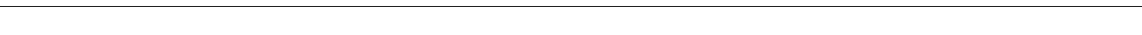
Fig. 4 Epigenetic features of H2A.Zac re-distribution at genomic regulatory regions. LHS, Venn diagrams overlapping the H2A.Zac gained or lost peaks from each different regulatory region (from Fig. 3a) with the corresponding “ unique ” active enhancers a , poised enhancers b , active promoters c and bivalent promoters d . The terminology “ unique ” was used to call enhancers or promoters that were only present in LNCaP but not in PrEC, for the gained peaks; and the enhancers and promoters that were only present in PrEC but not in LNCaP for the lost peaks. Box plots were generated to address the correlation of gain and loss of H2A.Zac peaks at the unique enhancers (active, a and poised, b or promoters (active, c or bivalent d ) with gene transcriptional regulation. The logarithmic fold change expression (logFC) of LNCaP minus PrEC was compared between all genes and the overlapping regions from the corresponding Venn diagrams. To associate gene expression with enhancers, all the genes upstream or downstream of a particular enhancer within a 25 kb window were assigned as an enhancer-gene association a and b RHS, two types of NOMe plots were generated to evaluate differential chromatin accessibility, (represented as 1 minus GpC methylation ratio) and differential DNA methylation 0 – 1 ratio) between LNCaP (red) and PrEC (green). The regions analyzed corresponded to the overlapping areas from the corresponding Venn diagrams for active enhancers a , poised enhancers b , active promoters c and bivalent promoters d . * t -test p- value < 0.05 ** t -test p- value <